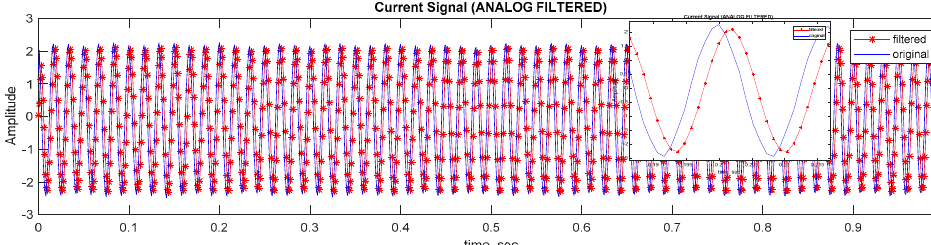
Figure 15. Downsampled low pass filtered current signal of measurement of motor line current of phase A at 60 Hz operation.